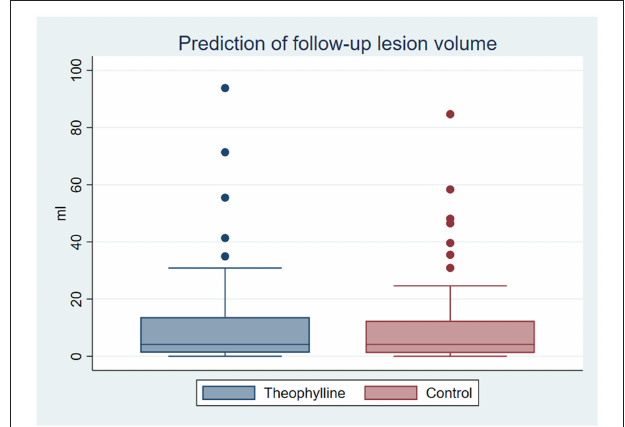
FIGURE 1 | Predicted volume of follow-up lesions. Box-whisker diagram depicting the mean predicted volumes of follow-up lesions based on the trainings datasets of patients treated with theophylline and placebo: Interquartile range with median (box), lower and upper interquartile + 1.5 interquartile range (whisker), and outliers (dots).